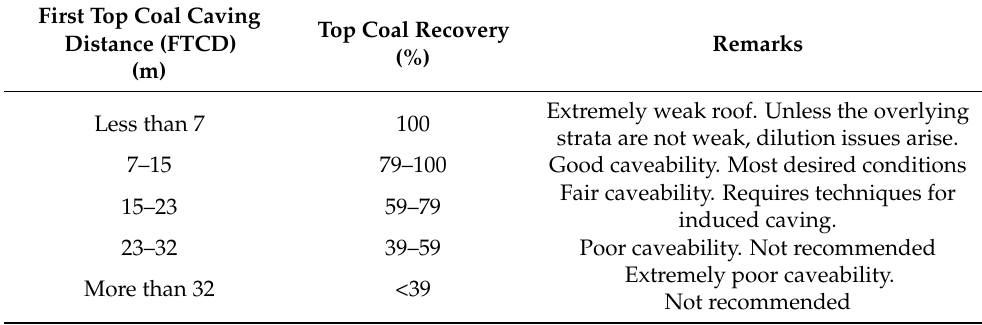
Table 1. Classification of caveability by FTCD and TCR (adapted from Vakili and Hebbelwhite [13]). First Top Coal